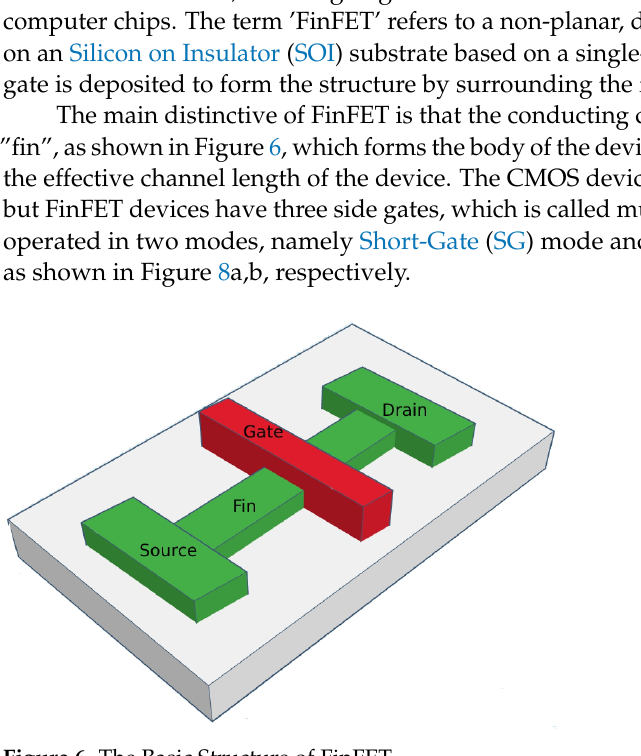
Figure 6. The Basic Structure of